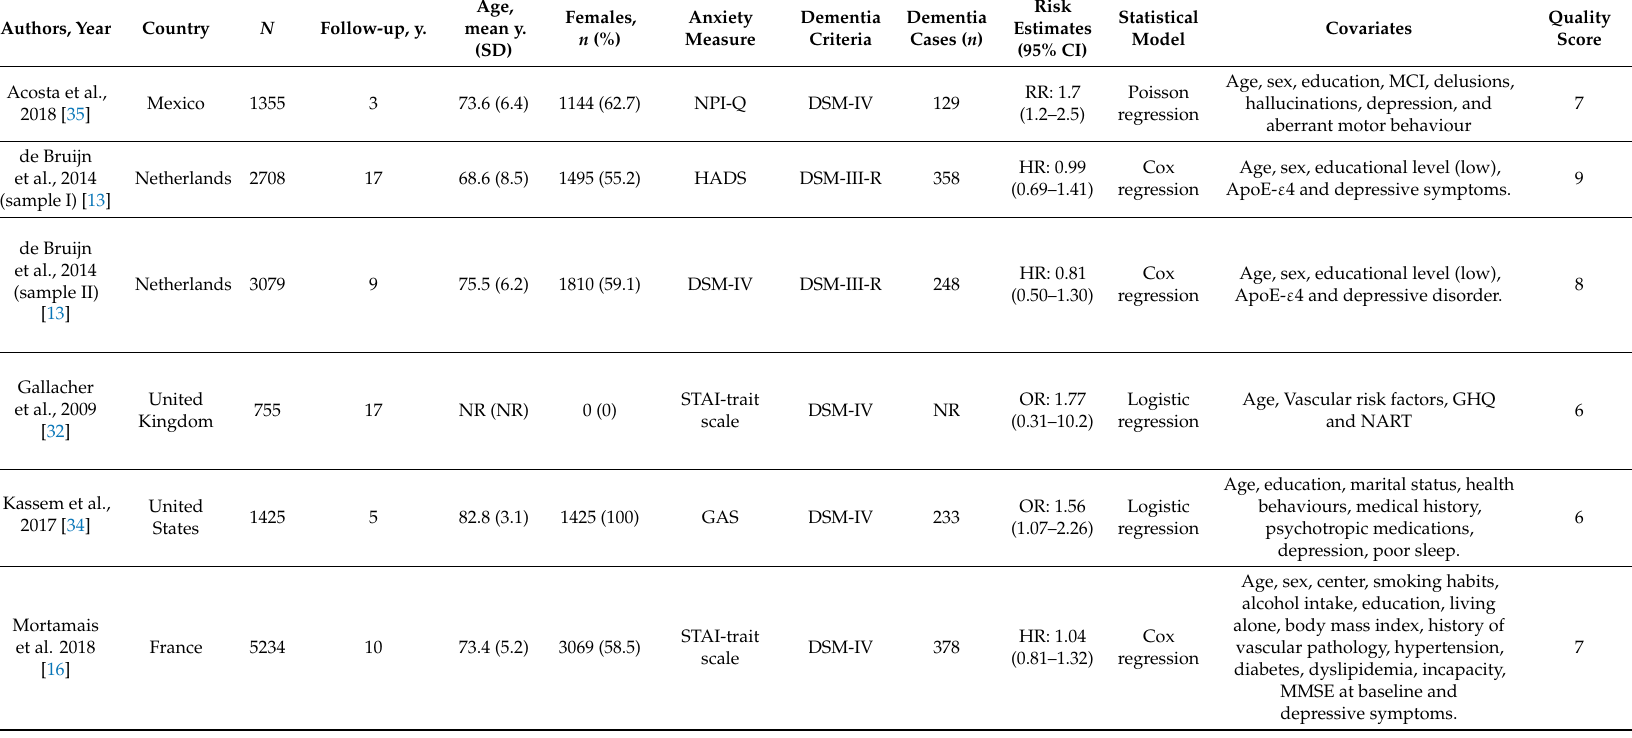
Table 1. Characteristics of the studies included in the